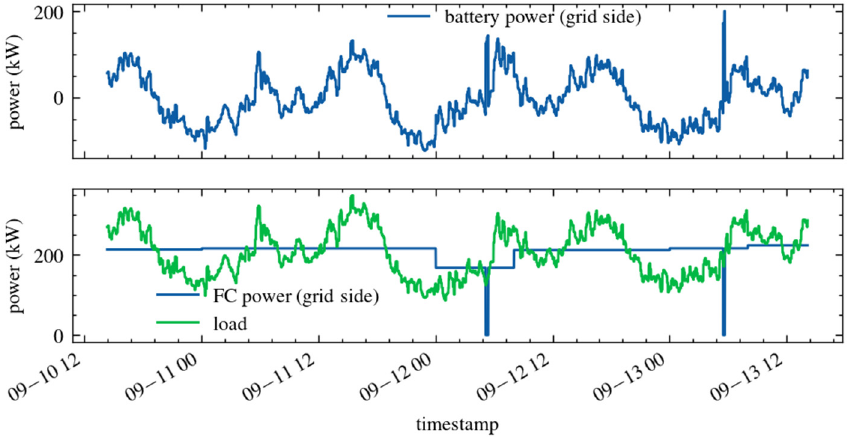
Figure 14. Grid-side powers in Scenario 3 (timestamp is in “month-day hour” format).